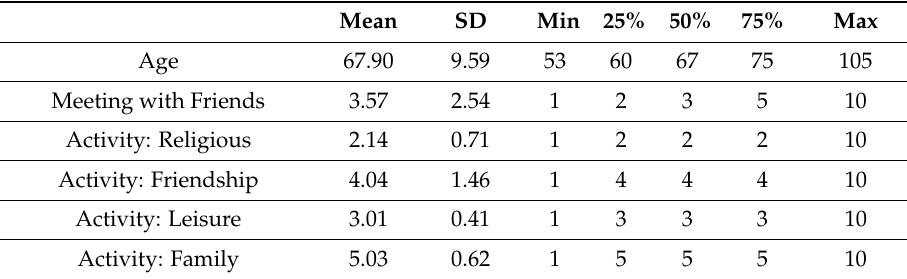
Table 2. Descriptive statistics for the participants’ continuous